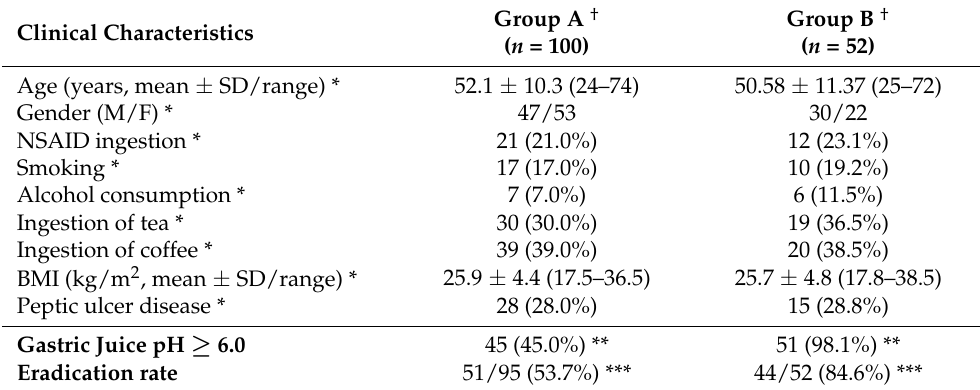
Table 5. Eradication rates of ILTHPI without and with stomach acid